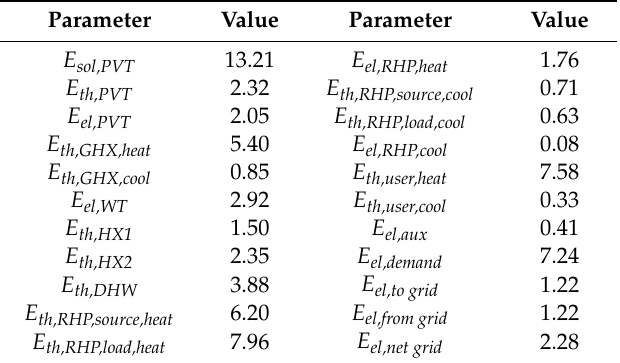
Table 4. Main thermal and electrical energies of the system in MWh, yearly